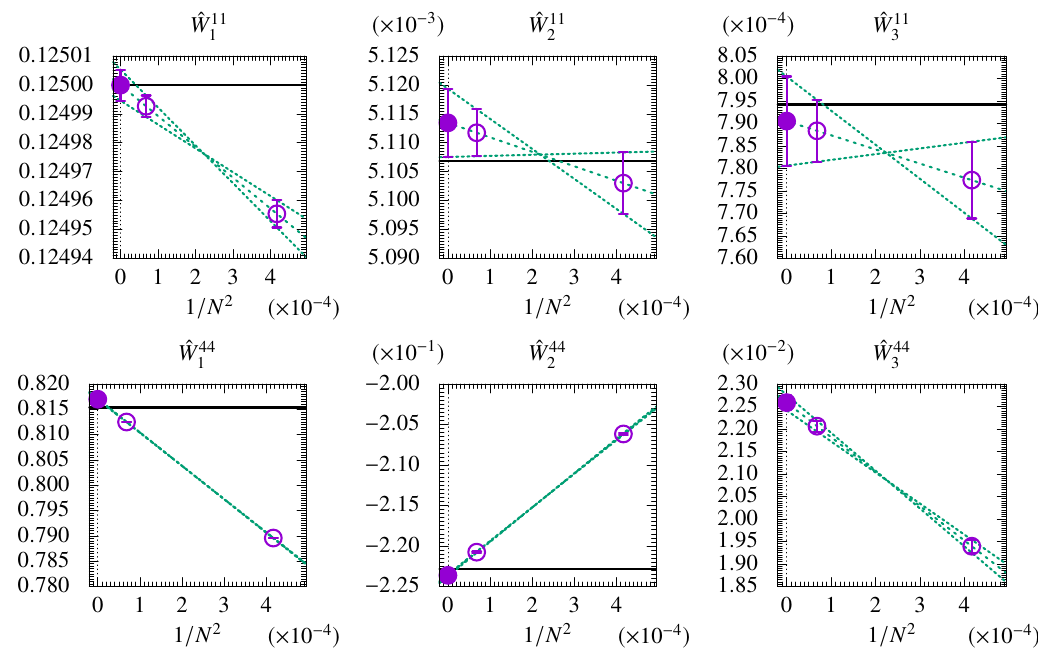
Figure 4. N ! 1 limit of perturbative coe(cid:14)cients using data from ( N; k ) = (49 ; 2) and (121 ; 3) (upper: plaquette, lower: 4 (cid:2) 4 Wilson